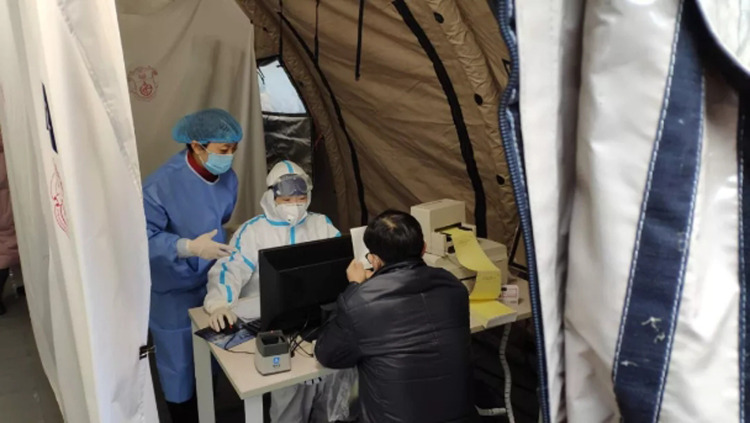
Consultation Room.